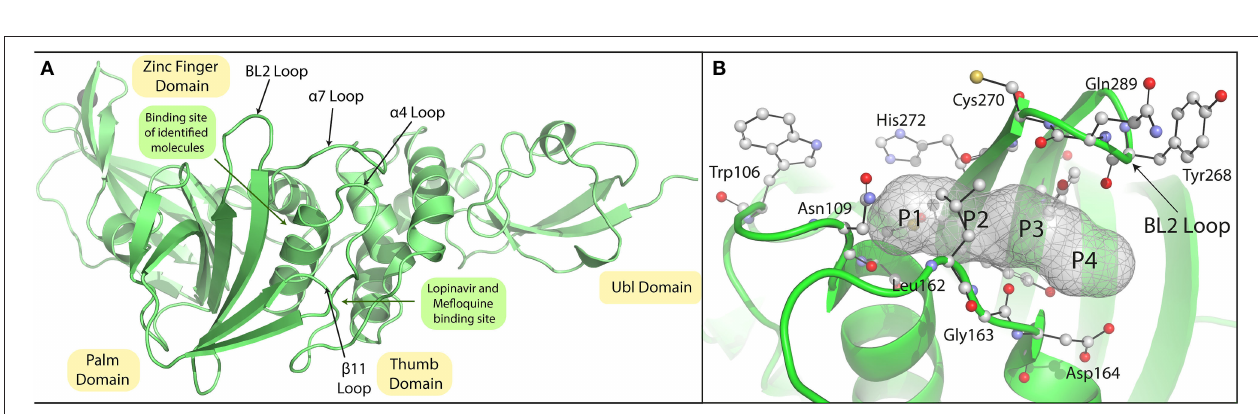
FIGURE 11 | Crystal structure of SARS-CoV-2 PLpro and substrates pocket. (A) SARS-CoV-2 PLpro crystal structure (PDB ID:6WX4) highlighting the subdomains Ubl, Thumb, Zinc finger, and Palm domain highlighted in yellow colour. Active site loops are indicated by arrows. (B) P1-P4 positions of the peptide LRGG (PDB ID:4M0W) superimposed on SARS-CoV-2 PLpro (PDB ID:6WX4) are shown with mesh model and active site residues of these residues are shown with stick model.